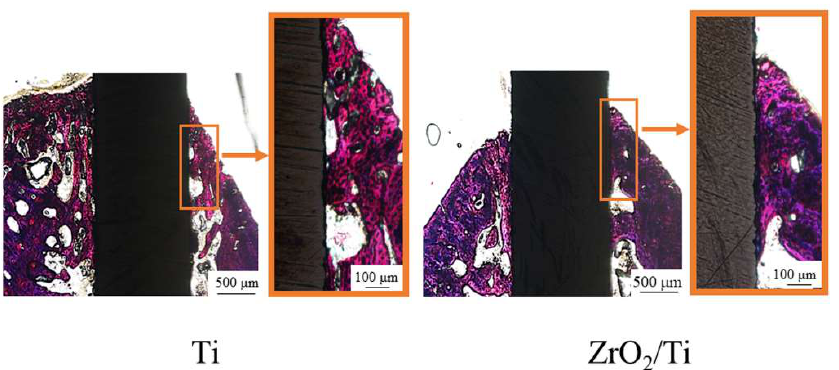
Figure 13. Histological appearances after 2 weeks of implantation into the femur bone defects of rats (magnification of ×40 and ×100).